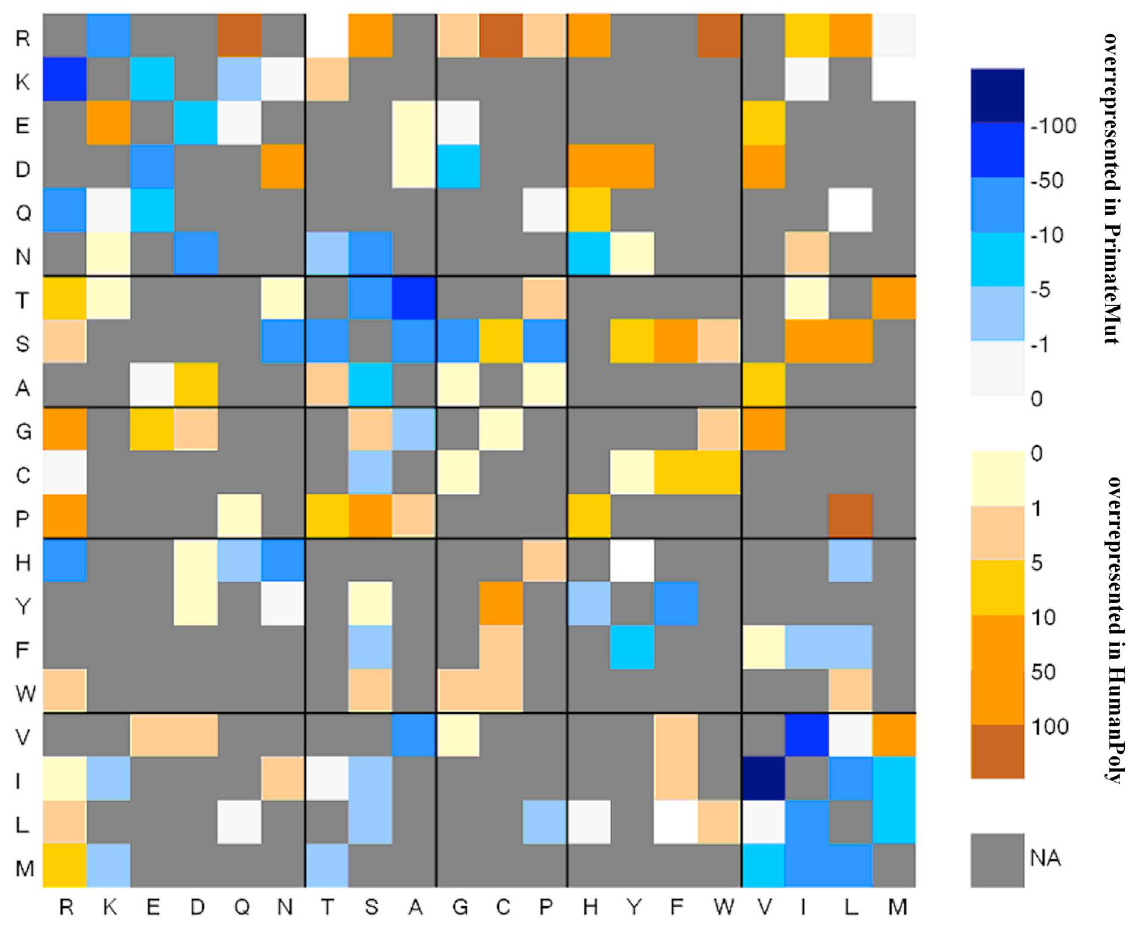
Figure 1. The contributions to G for HumanPoly and PrimateMut . Only those 150 mutations accessible by single-nucleotide changes are shown in color; others are shown in gray. Wildtype residue types are given along the x-axis and mutant residue types are given along the y-axis. Blue squares indicate substitution types that are overrepresented in PrimateMut , while orange squares indicate substitution types that are overrepresented in HumanPoly .